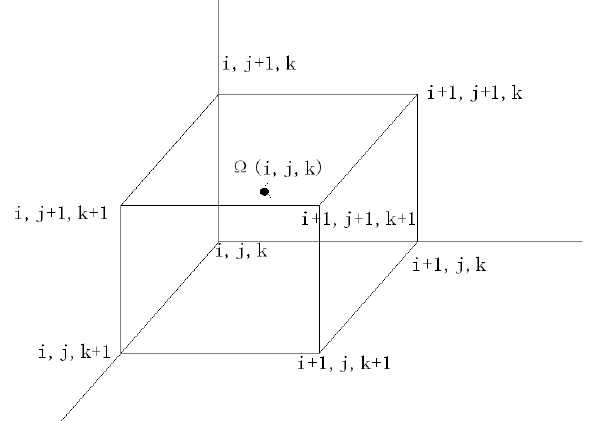
Figure 2. Schematic diagram of finite volume grid element Ω ( i , j , k ) .